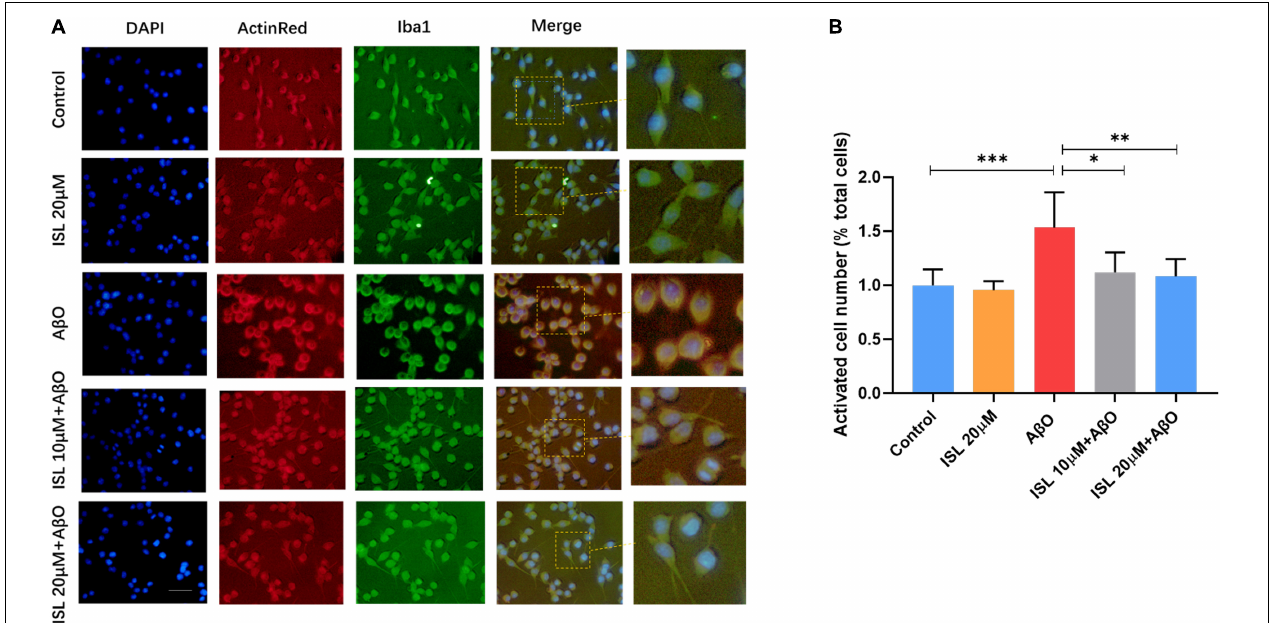
FIGURE 3 | ISL suppressed the morphological changes of BV2 cells exposed to A β O. BV2 cells were pre-treated with 20 µ M ISL for 2 h and then co-treated with 5 µ M A β O for 6 h. (A) Iba1 and Actin Red was used to assess the morphological changes of BV2 cells. (B) ISL treatment suppressed the morphological changes in